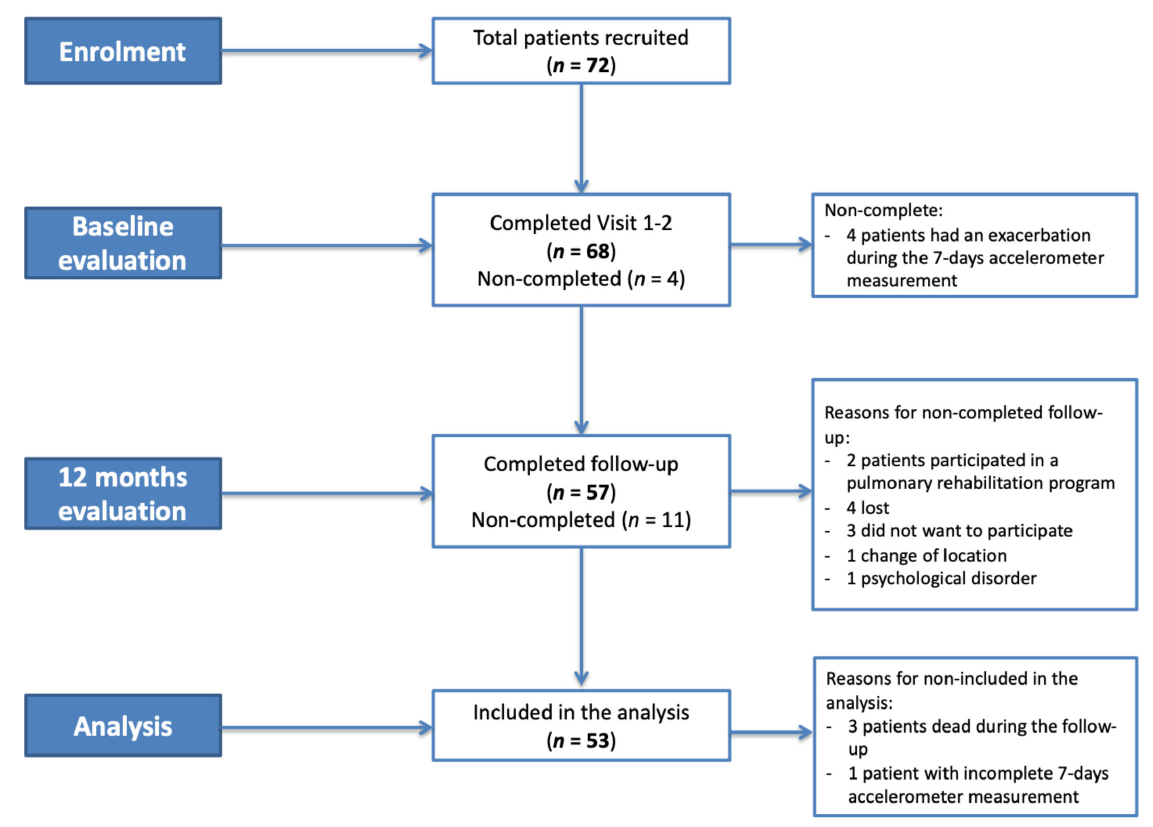
Figure 1. Enrolment flow-chart.